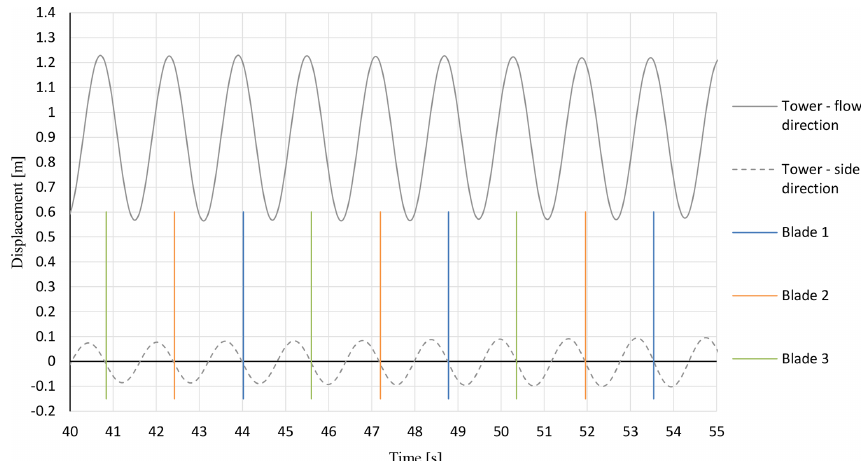
Figure 10. Tower displacement.